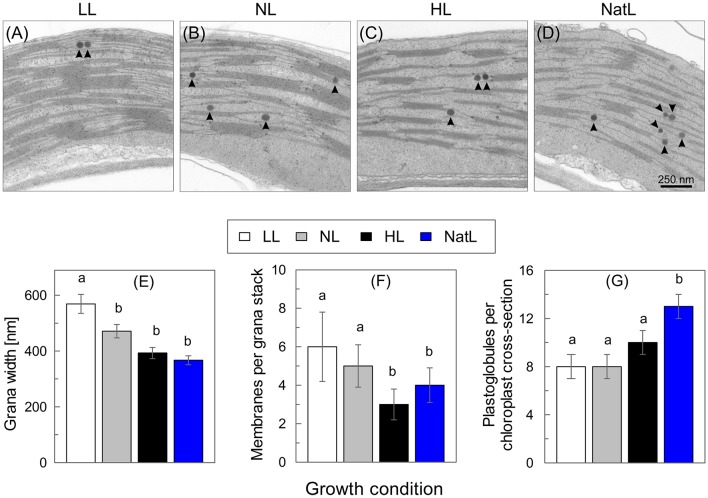
Transmission electron microscopy analysis of chloroplasts. Upper panel: Electron microscopic images of the thylakoid membrane structure of (A) LL plants, (B) NL plants, (C), HL plants, and (D) NatL plants. Round dark structures (arrow heads) represent plastoglobules. Lower panel: Quantification of (E) the width of grana stacks, (F) the number of membranes per grana stack and (G) the number of plastoglobules. Mean values ± SE of at least six images are shown. Significant differences (Dunn's test, p < 0.05) are indicated.